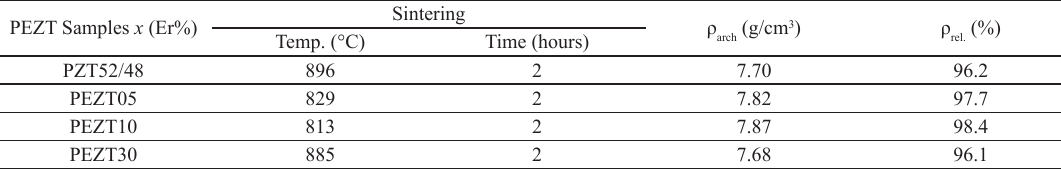
Table 1. Sintering parameters and final density of the prepared PEZTceramics samples. PEZT Samples x (Er%)